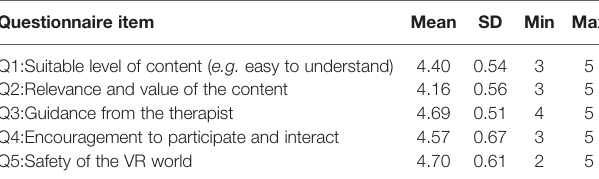
TABLE 2 | Acceptability ratings (0 – 5) for each item of the feedback